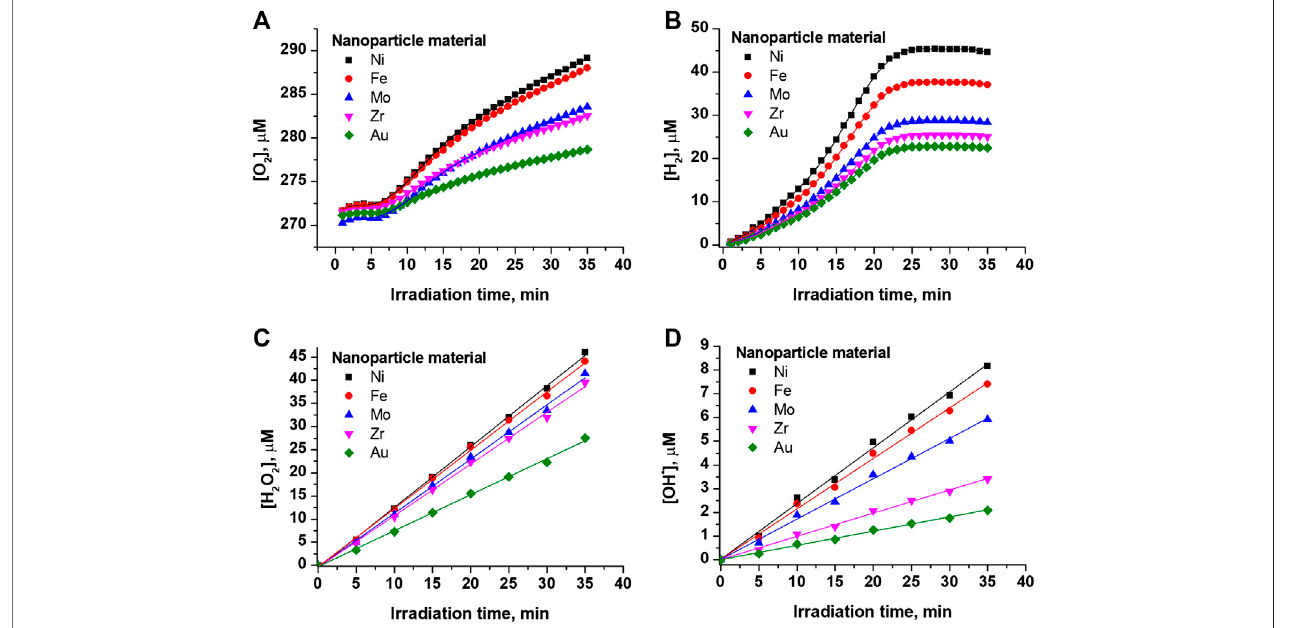
FIGURE2| Concentrationchangevs.irradiationtimeofthecolloidalsolutionofnanoparticles (A) molecularoxygen (B) molecularhydrogen (C) hydrogenperoxide (D) hydroxyl radicals.